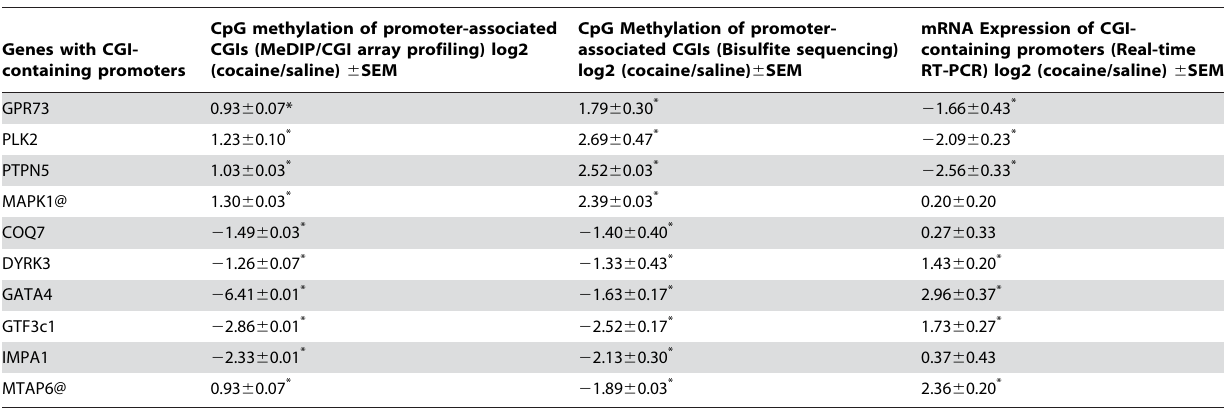
Table 4 . Comparison of the MeDIP/CGI array profiling-defined methylation states of promoter-associated CGIs, promoter bisulfite sequencing-derived percentages of methylated CpGs, and RT-PCR-based expression levels for 10 selected genes between the hippocampal pyramidal layer of 3-day-old male offspring of saline-control mothers and the corresponding tissue of parallel pups born by cocaine-treated females.